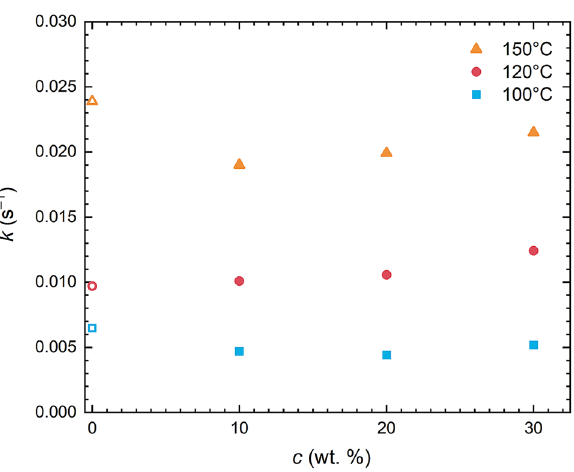
Figure 6. Dependence of rate constant, k , on curing temperature and oil content, c.